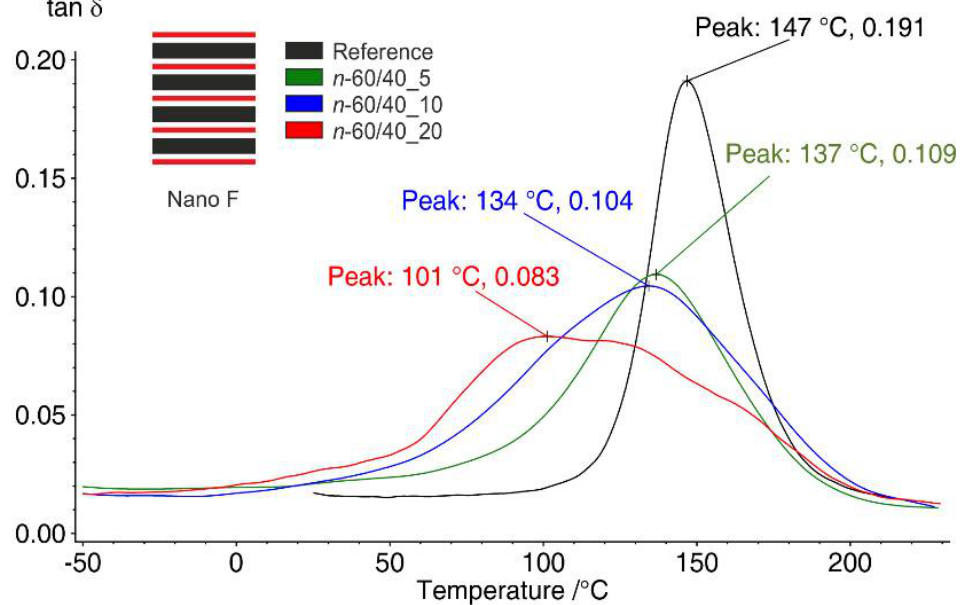
Figure 9. Tan δ curves of Nano F laminate Figure 9. Tanδ curves of Nano F laminate configuration.